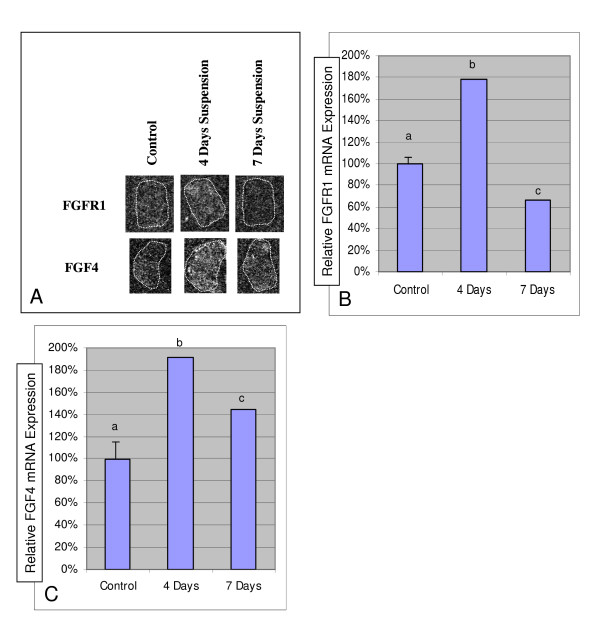
FGFR1 and FGF4 mRNAs are up-regulated in muscle undergoing disuse atrophy. FGFR1 and FGF4 mRNAs were analyzed in sections of gastrocnemius muscle obtained from control mice or mice suspended for 4 or 7 days by in situ hybridization. In comparison to controls, FGFR1 and FGF4 mRNA signal, as depicted by white silver grains in dark field images, were upregulated in gastrocnemius muscles suspended for 4 days (A). Direct dpm analyses were obtained using the Cyclone Storage Phosphor System, and FGFR1 and FGF4 mRNA levels were found to be significantly greater in muscles suspended for 4 days than control muscle or muscle suspended for 7 days. Dotted lines represent the outline of the gastrocnemius muscles. SEM indicated over control; means with different superscripts differ p < .05; n = 10 for each mean.